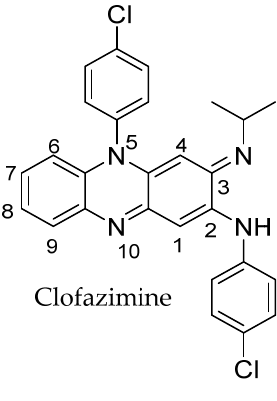
Figure 1. Structure of clofazimine.